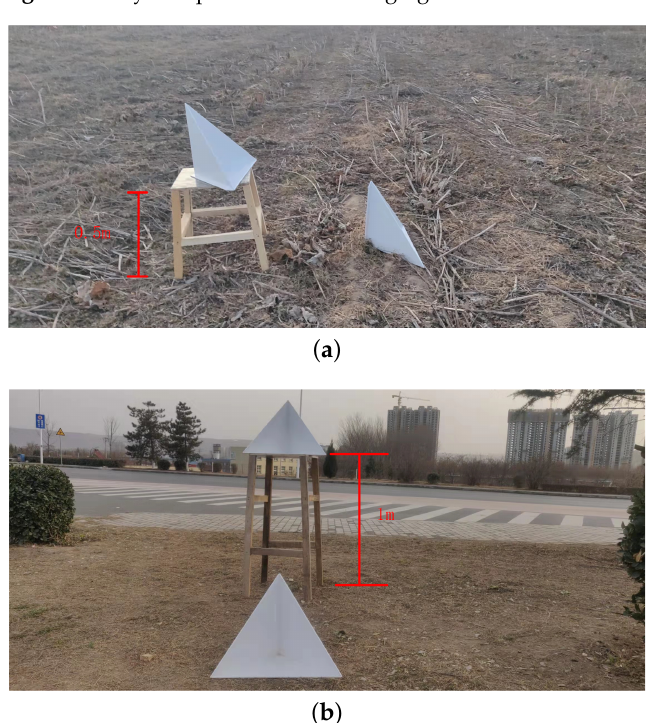
Figure 12. Layover scalers physical drawing. ( a ) Two targets interval 0.5 m. ( b ) Two targets interval 1